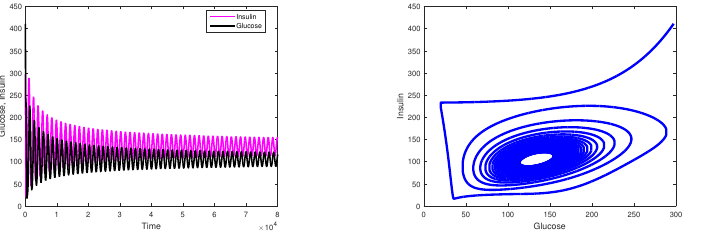
Figure 8. Glucose-insulin dynamics: dynamics and phase plain for τ • = 228 min.